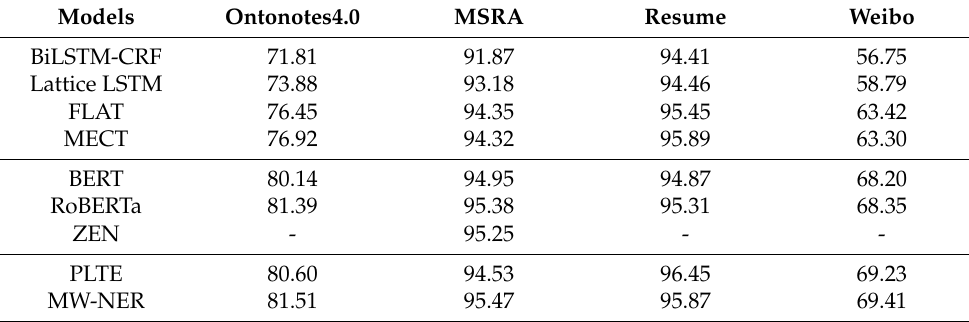
Table 2. The performance of methods on four datasets (%).